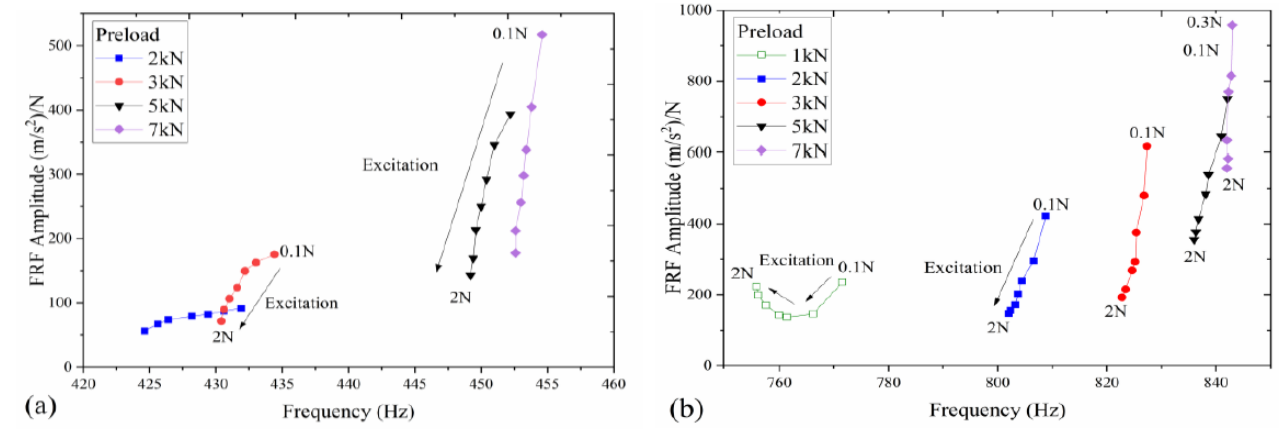
Figure 18. FRF peak point under various condition, ( a ) two-beam joint, ( b ) one monolithic beam.